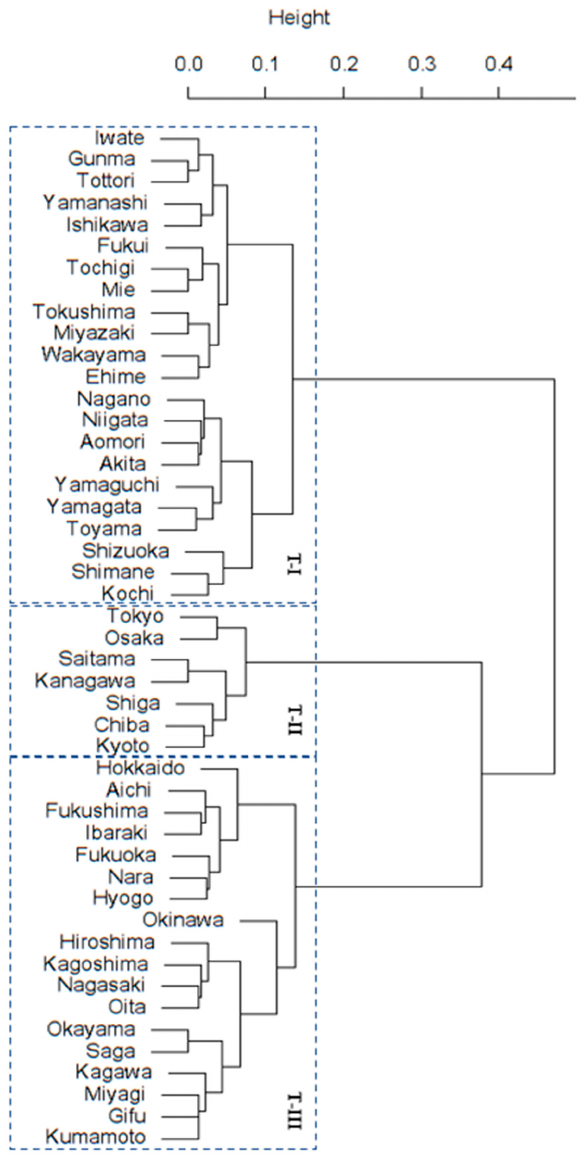
Figure 4. A dendrogram for vehicle body type. See Figure A1b for the mapping of the cluster analysis results.